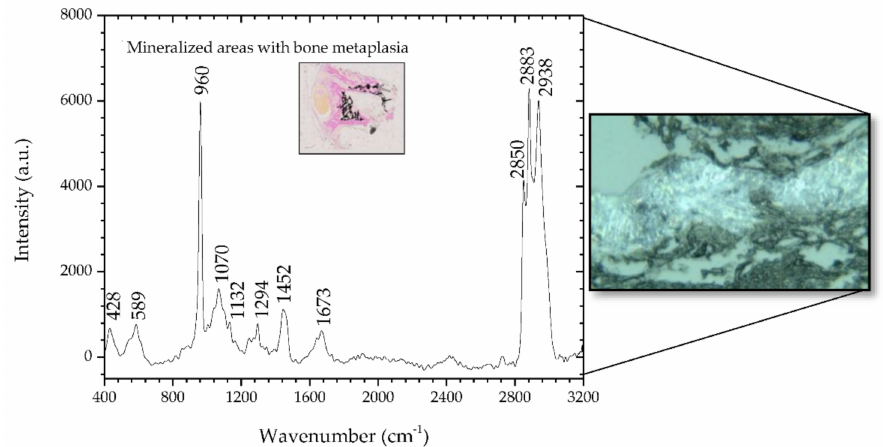
Figure 2. Raman spectra of mineralized areas of a benign mixed tumor (sample #1) and, on the right side, the corresponding microscopic image (50 × , Raman spectrometer system). The inset shows the microscopic image (2.5 × ) of a section of sample #1 where mineralized areas are stained black by means of the Von Kossa-Van Gieson modified method.